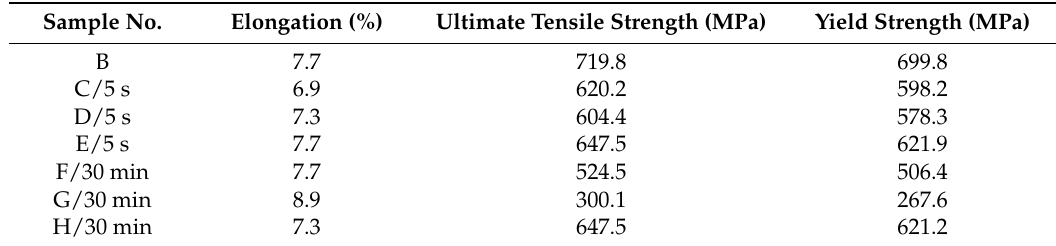
Table 3. Mechanical properties of the studied specimens subjected to isothermal heat treatments for different treatment parameters.